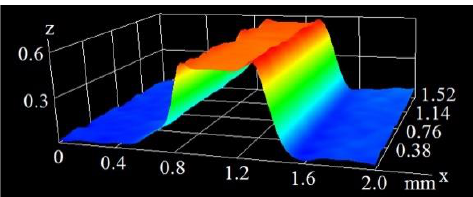
Figure 5. The image of a microfin from a pulse duration of 60 ns and velocity of 200 mm/s.